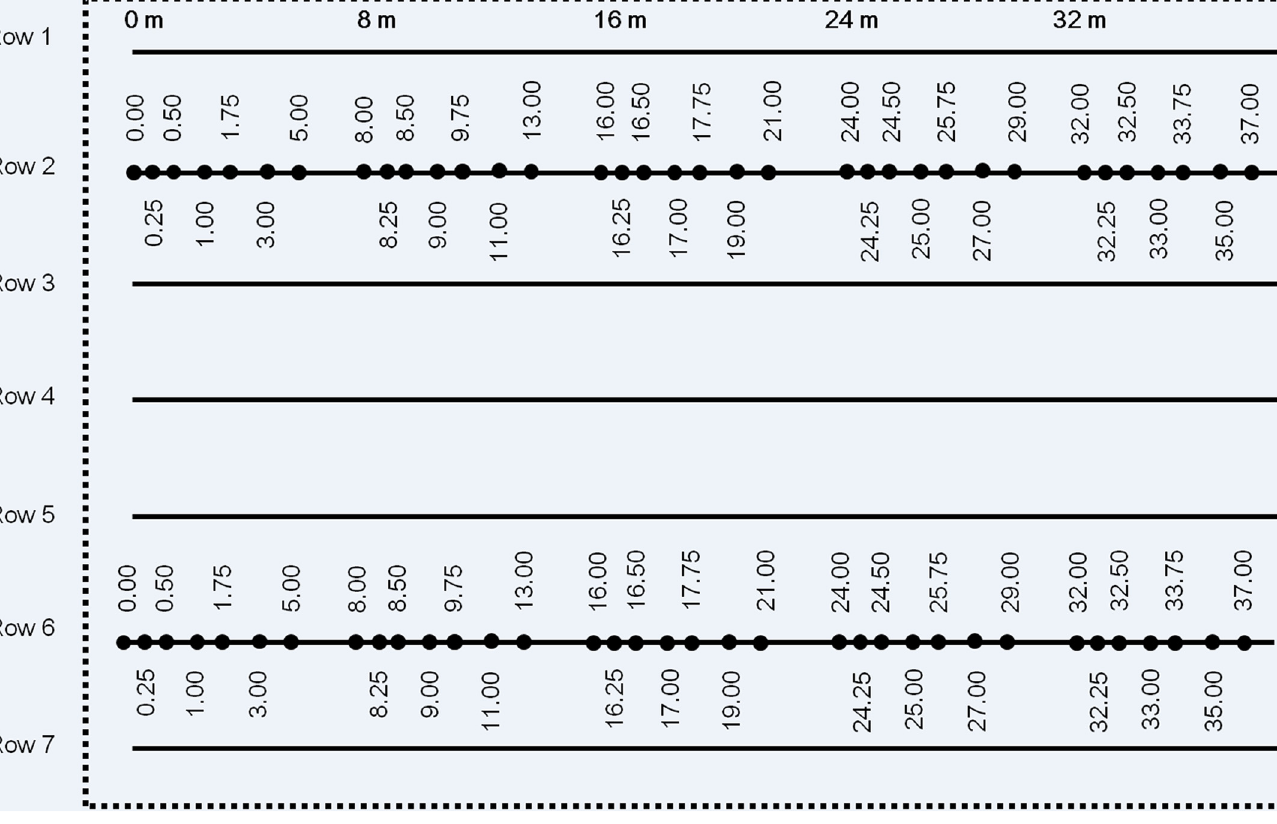
Fig 1. A diagram illustrating the point sample positions. Soil was sampled in three commercial cotton fields to study spatial relationship in the density of Verticillium dahliae inoculum. Numbers indicate the distances (m) from sampling points to first sampling point in the same row. Sampling was conducted in three commercial fields in late August 2013, Weinan, Shaanxi Province,